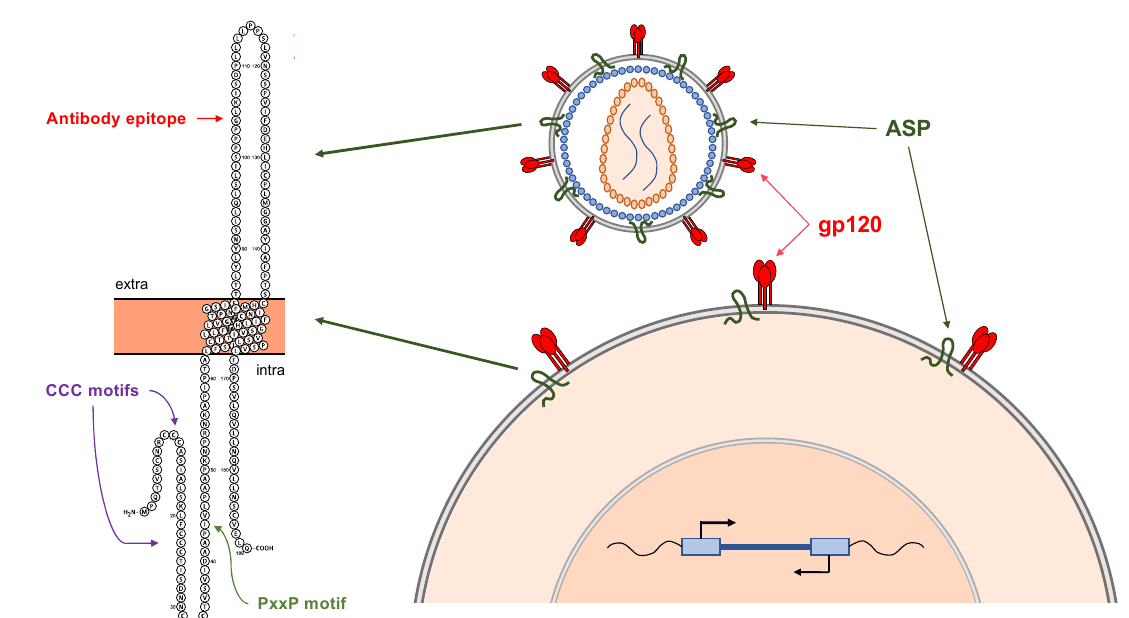
Figure 4. Association of ASP with the plasma membrane and the viral envelope. Studies from our and other groups have shown that ASP is expressed on the surface of productively infected cells. In addition, our studies demonstrate that ASP co-localizes with gp120 on the surface of primary HIV-infected CD4+ T cells and macrophages. A putative model of membrane-associated ASP is shown on the left side of the figure. According to this model, the N-terminus and C-terminus of ASP are intracellular (or intraviral), while the segment between the two transmembrane domains is exposed in the extracellular (or extra-viral) milieu. This model is supported by evidence that our monoclonal antibody directed against an epitope in the predicted extracellular loop of the protein (residues highlighted in red) can detect ASP on the cell surface in flow cytometry and confocal microscopy studies without the need from membrane permeabilization [57]. The same monoclonal antibody could detect ASP on the surface of viral particles (fluorescence correlation spectroscopy), and could capture HIV-1 virions (virion capture assay) [57].